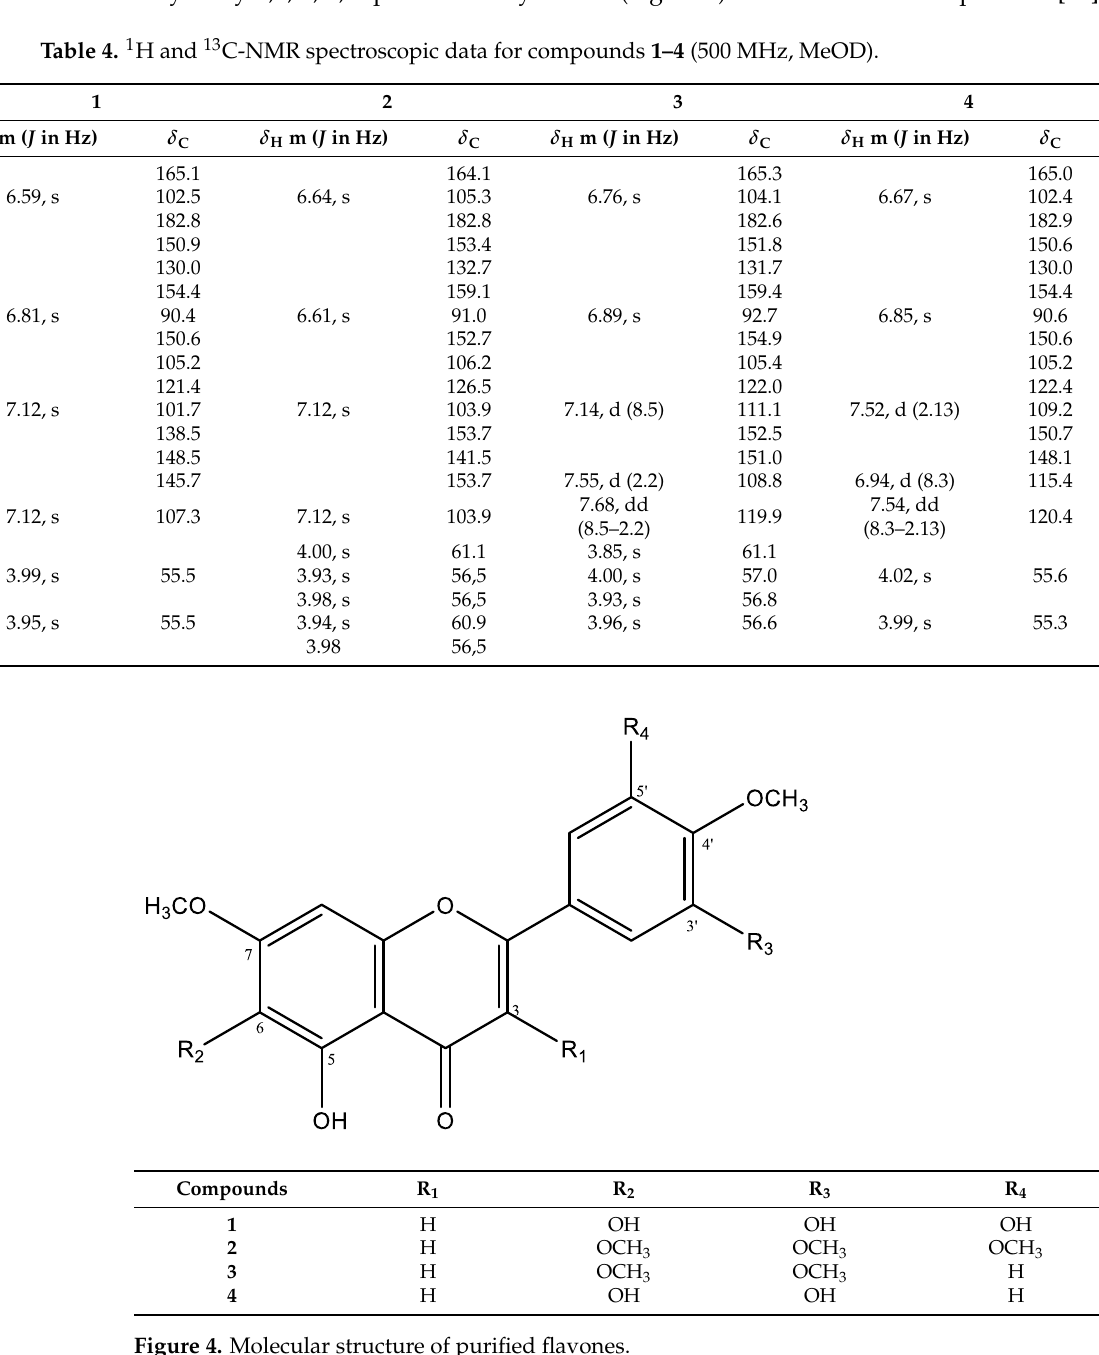
Figure 4. Molecular structure of purified